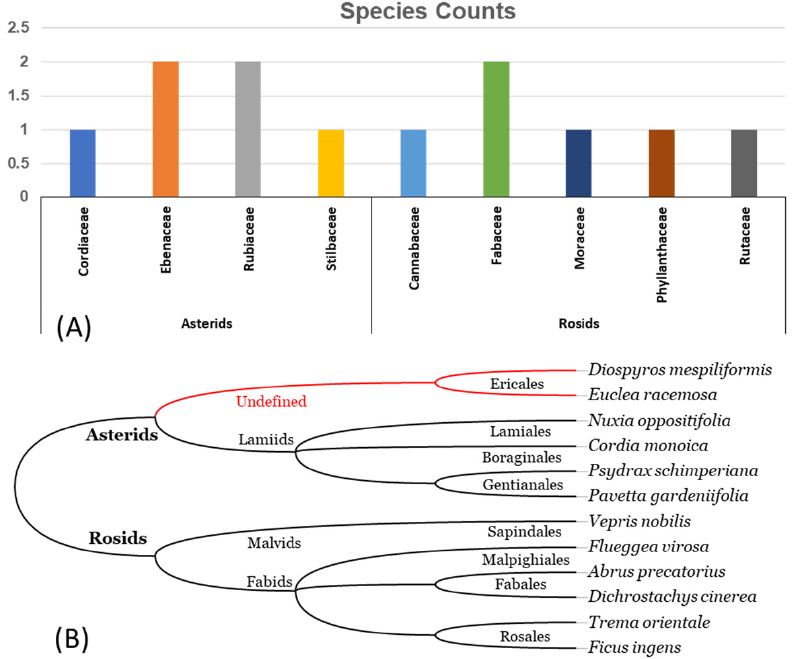
Figure 2. The counts ( A ) and the literature-based phylogeny ( B ) of the twelve collected plant sam- from the Faifa mountains based on observation and visual ples from the Faifa mountains based on observation and visual inspection.